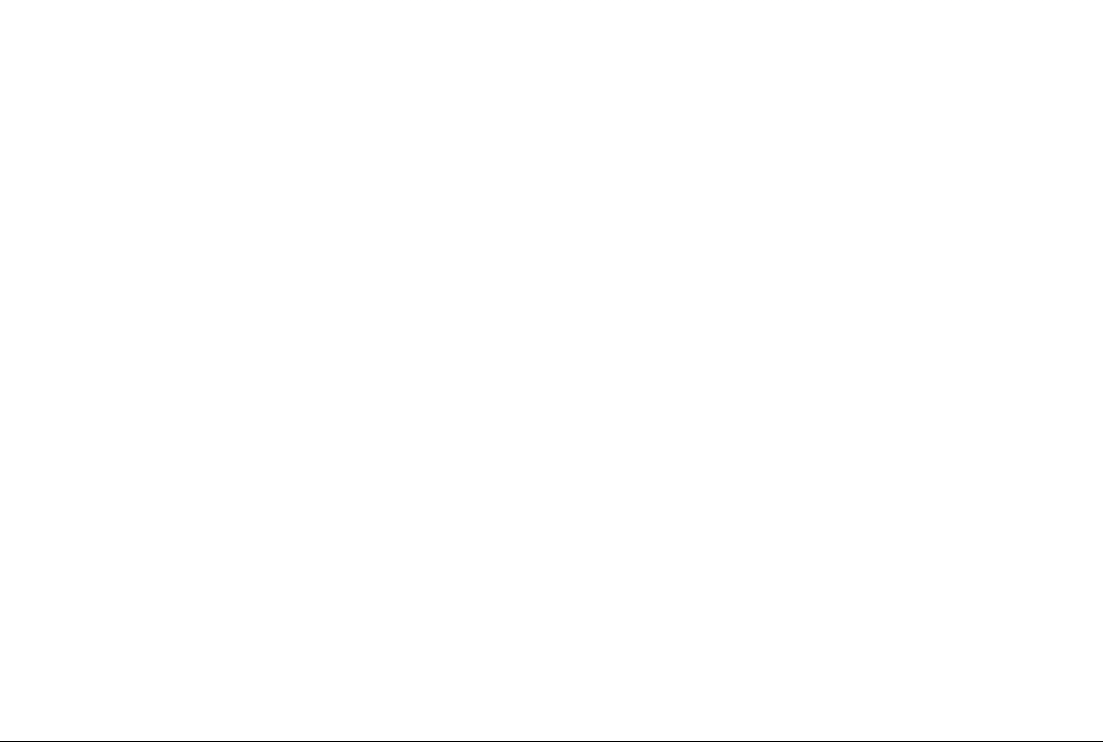
Figure 3. Kaplan–Meier survival plot of time to death in asthmatic patients with comorbidities, asthmatic patients without comorbidities, and subjects without asthma. ( a ) COPD, ( b ) pneumonia, ( c ) bronchiectasis, and ( d ) lung cancer. COPD, chronic obstructive pulmonary